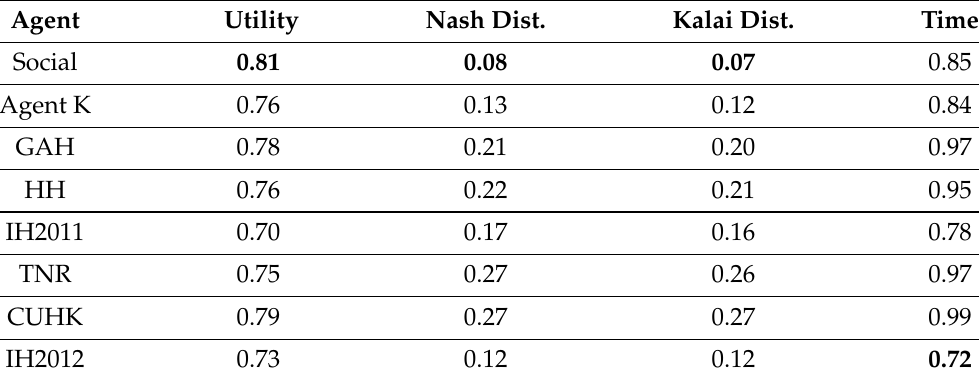
Table 4. Average utility, distance to the Nash point, distance to the Kalai point, and negotiation time for the agents when facing themselves and all other opponents in the specified domains. The best performing values are in